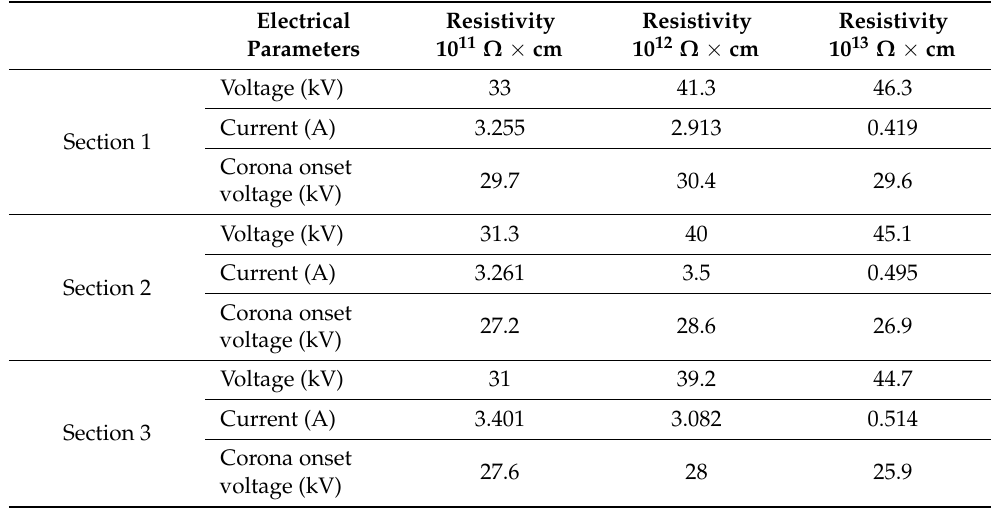
Table 6. Electrical parameters for full-wave rectified voltage, with a 2 mm dust layer on the section surfaces, and for three resistivities.